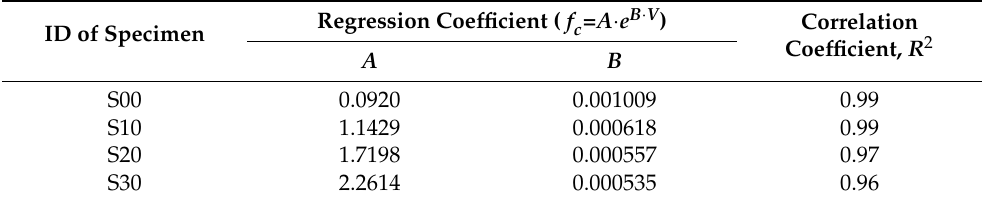
Figure 11. Exponential relationship between UPV and compressive strength according to the replace- ment rate of SF. Table 3. Regression coefficient and least square of each specimen for compressive strength and UPV